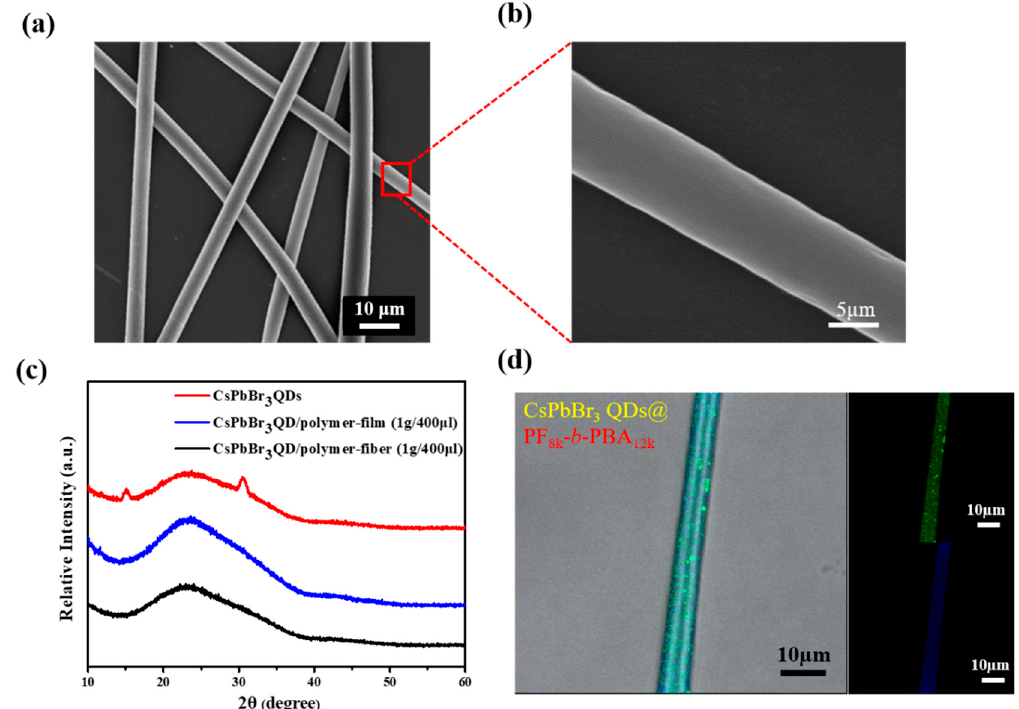
Figure 2. ( a , b ) SEM images of the CsPbBr 3 @PF 8k - b -PBA 12k fibers (1 g / 400 µ L). ( c ) XRD patterns of the